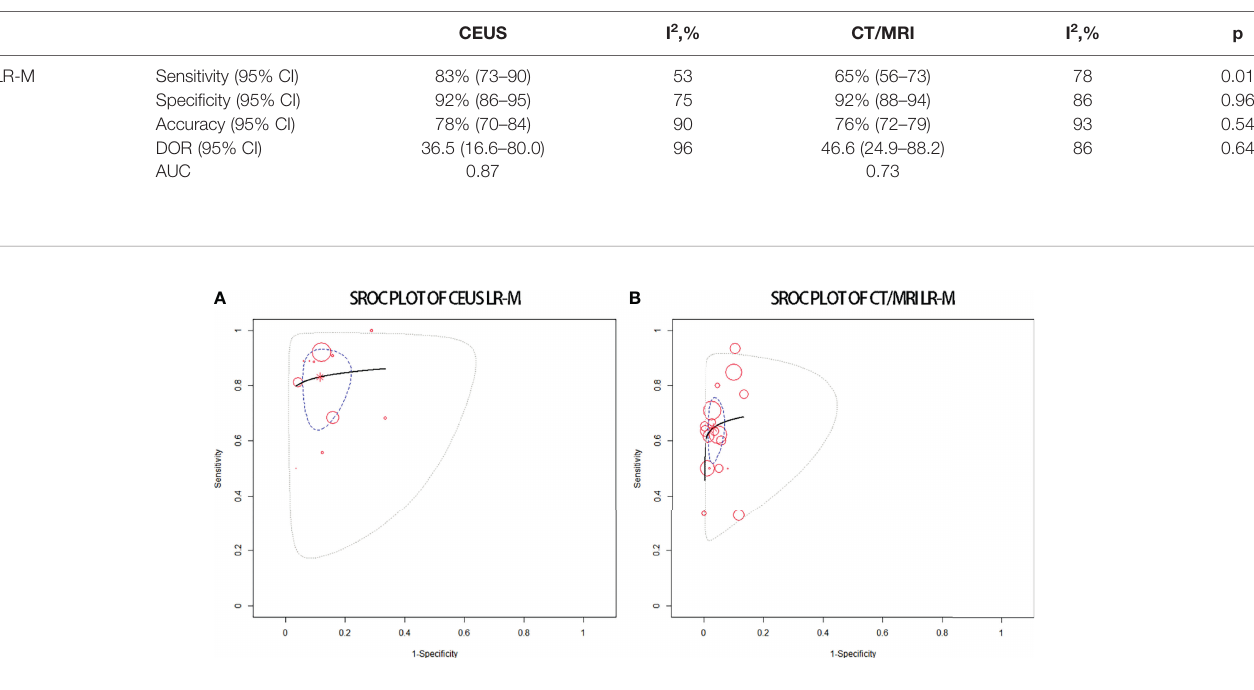
TABLE 4 | Diagnostic performance of CEUS and CT/MRI LR-M for non-HCC malignancies.